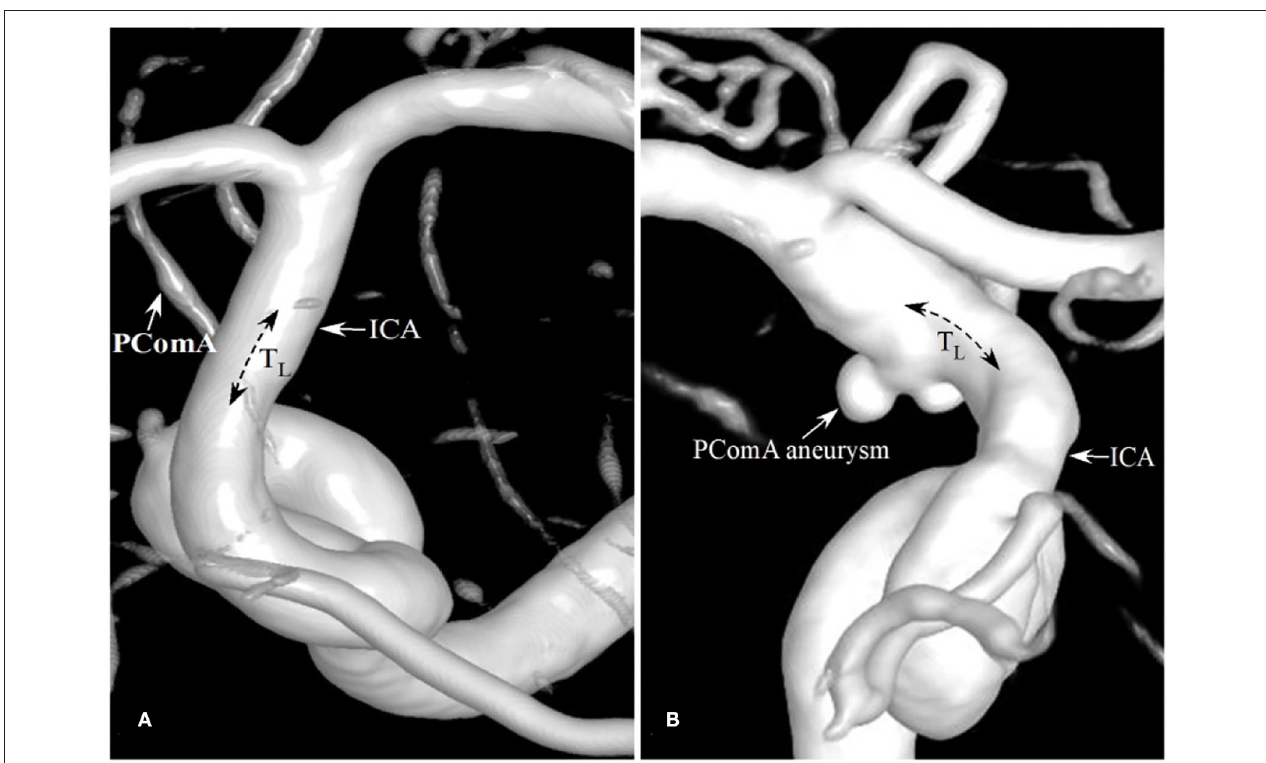
FIGURE 2 | Patients with the different degrees of tortuosity (T ICA ) of the PComA segment of the ICA. (A) A patient with no PComA aneurysms had the T ICA tortuosity of 0 at the PComA segment of ICA. (B) A patient with a PComA aneurysm had the T ICA of 0.05.